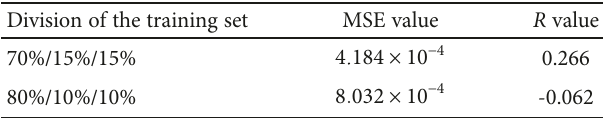
Table 13: Values of MSE and R depending on the division of the training set (for two neurons in the hidden layer and TRAINLM algorithm) in model ANN 4.